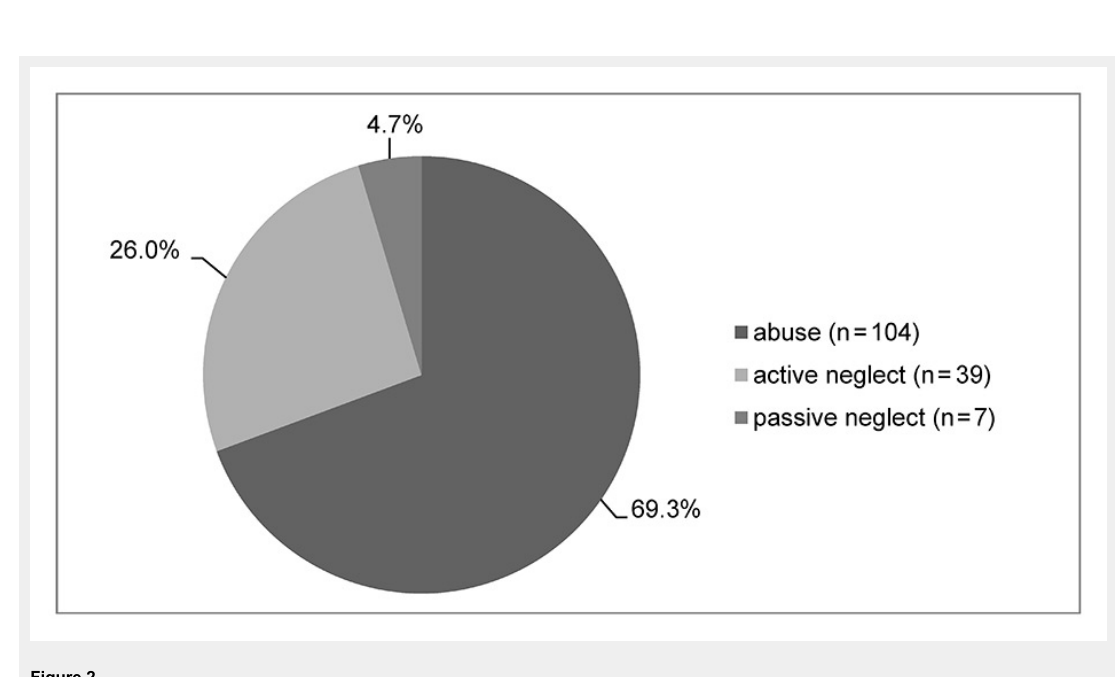
Figure 2 Distribution of neglect and abuse (n = 150